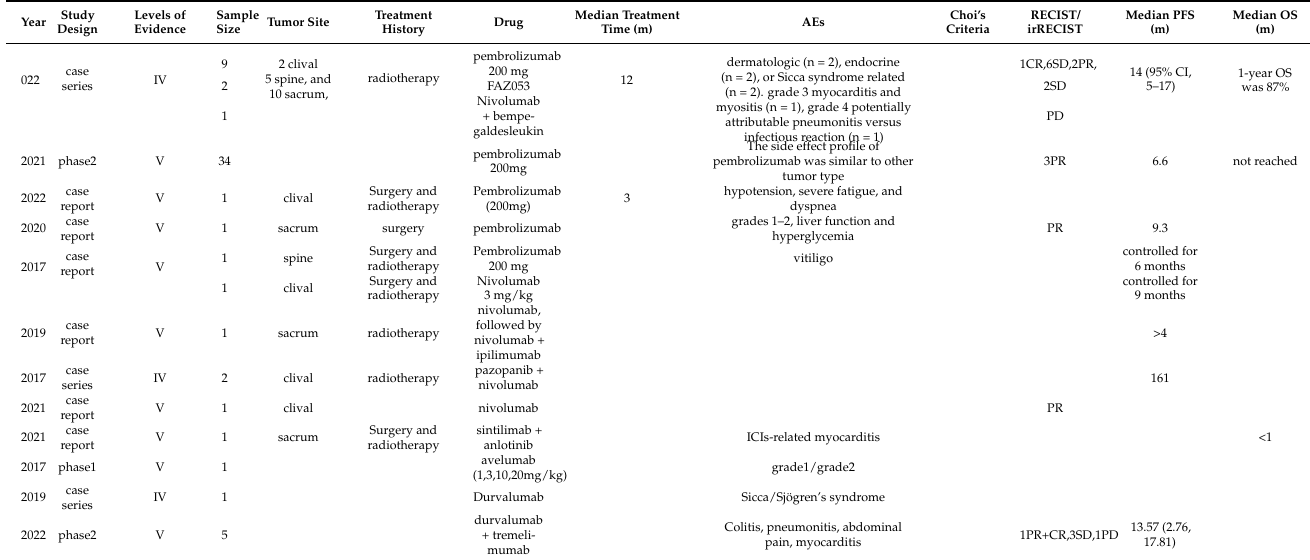
Table 1. Immunotherapy of chordomas with PD-1/PD-L1 immune checkpoint